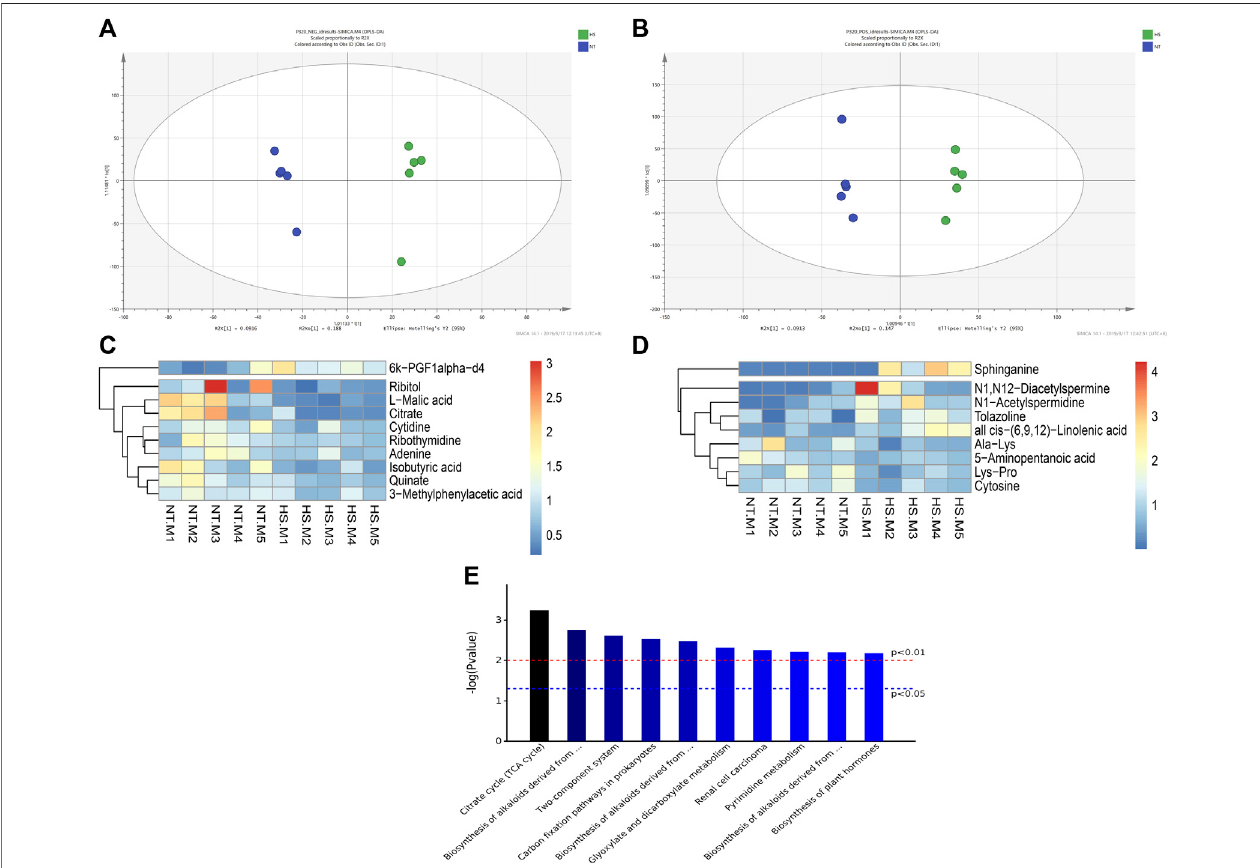
FIGURE 5 | Effects of heat stress on cecal metabolome in indigenous broilers (n = 5/group). (A) Orthogonal partial least squares discriminant analysis (OPLS-DA) under negative ions mode (NEG); (B) OPLS-DA under positive ions mode (POS); (C) Cluster heatmap analysis of samples under positive ions mode (POS); (D) Cluster heatmap analysis of samples under negative ions mode (NEG); (E) Kyoto Encyclopedia of Genes and Genomes (KEGG) metabolic pathways enrichment analysis; NT, normal treatment group (21.3 ± 1.2 ° C, 24 h/day), HS, heat stress group (32.5 ± 1.4 ° C, 8 h/day).